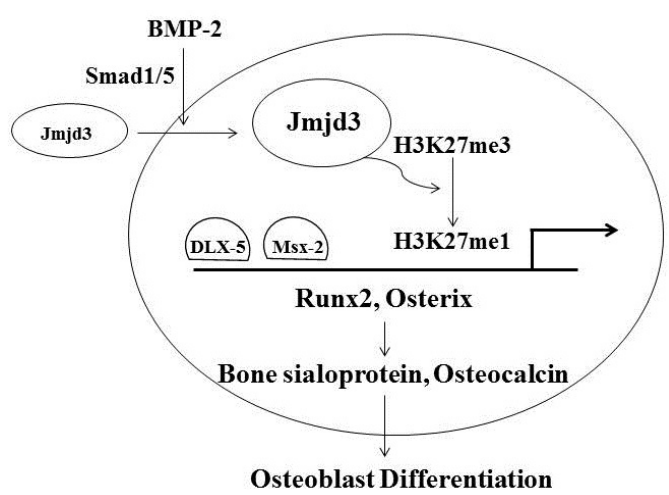
Figure 1. Jmjd3 regulates osteoblast differentiation through transcription factors Runx2 and Osterix. BMP-2 induces Jmjd3 expression and translocation into the nucleus, where the level of H3K27me3 on the promoter regions of Runx2 and Osterix decreases by demethylation. Thus, this further promotes Msx-2 and Dlx-5 to approach to the binding sites of these promoters, resulting in the up-regulations of Runx2 and Osterix.